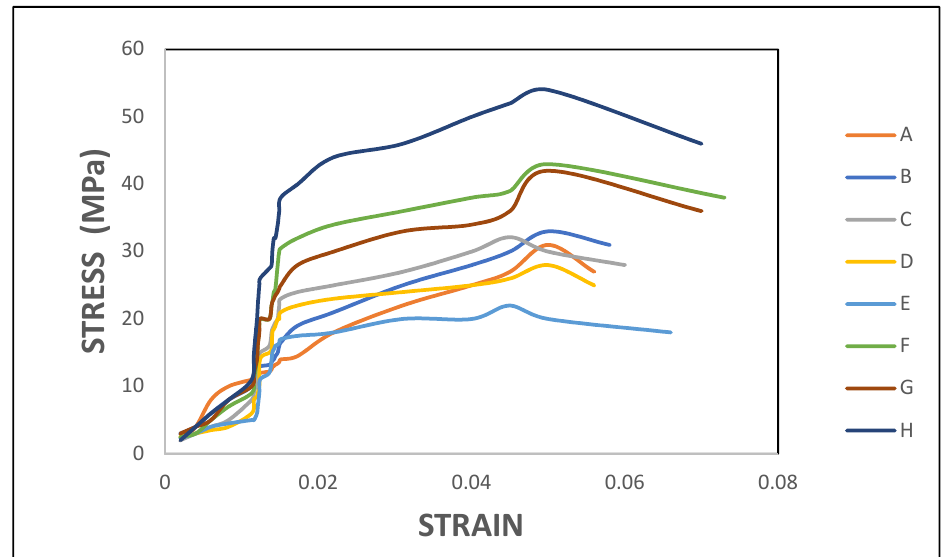
Figure 5. Stress vs. strain curve during tensile testing.